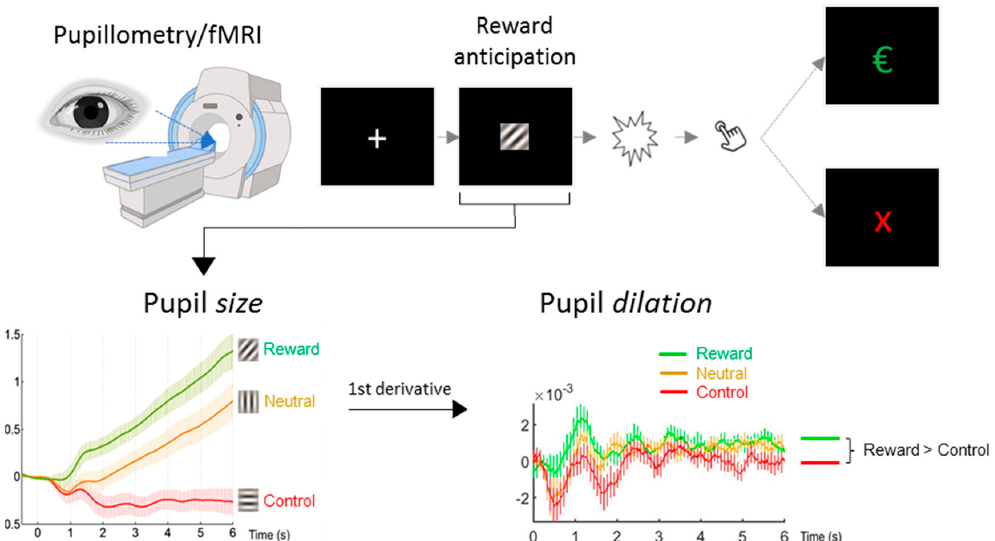
Figure 1. Graphic depiction of the reward anticipation task. Three isoluminant gabor patch stimuli with different stripe orientations were presented for 6 s. Pupil size was analyzed for the 6 s reward anticipation period; the increase or decrease of pupil size over time (first derivative) was used to quantify pupil dilation. Pupil dilation was averaged over the full anticipation period to obtain a robust score per stimulus and for the difference between the reward and nonresponse control stimulus. Values on the X-axis reflect time in seconds, on the Y-axes pupil size/dilation in z-transformed units. €, 1 Euro gain. X, no gain.